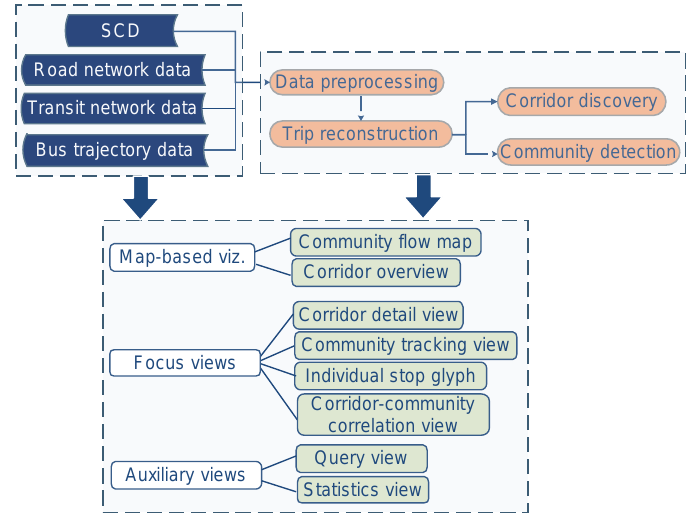
Figure 2. Overview of the proposed geovisual analytic approach. SCD—smart card data.